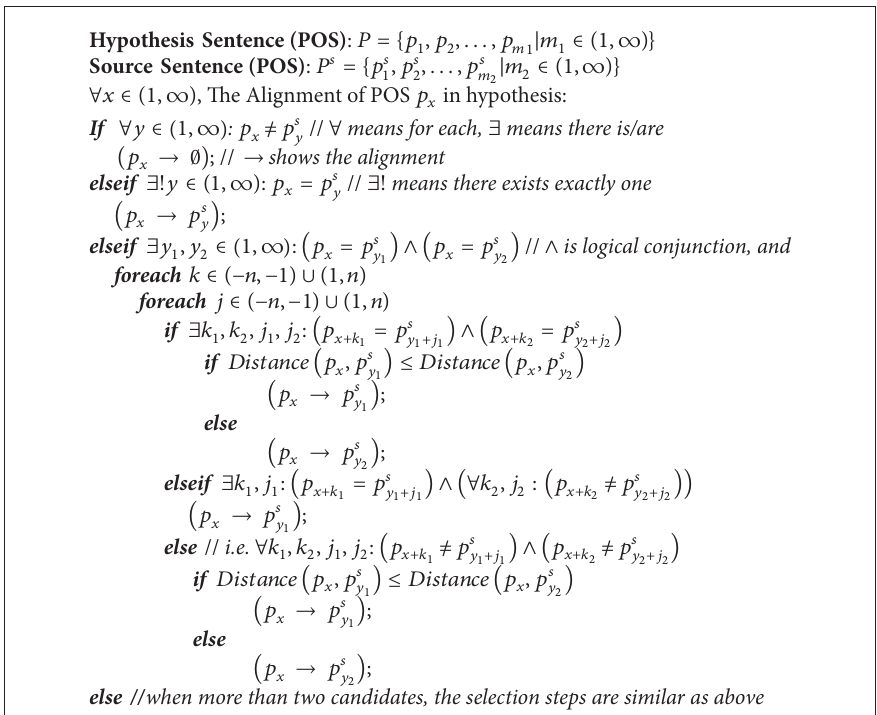
Algorithm 1: The POS alignment algorithm from hypothesis to source sentence based on 𝑛